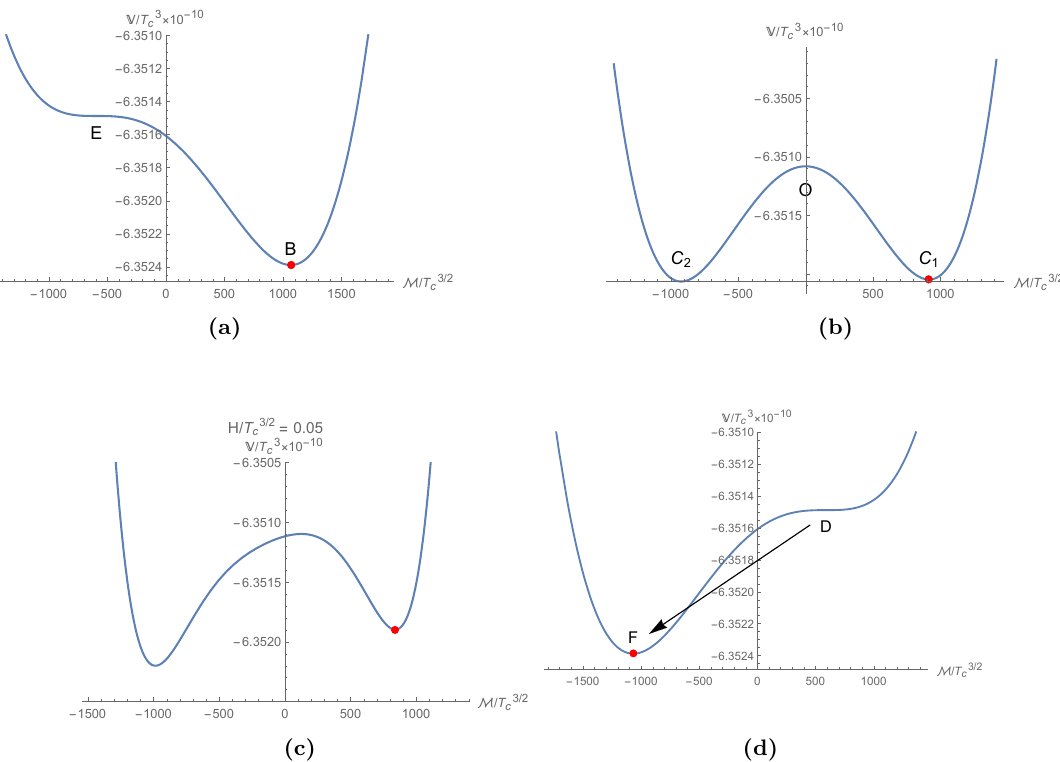
Figure 3 . Magnetization dependence of the e(cid:11)ective potential for given magnetic (cid:12)eld correspond- ing to (cid:12)gure 2. The potentials (a), (b), (c) and (d) are given upto M 6 -order.